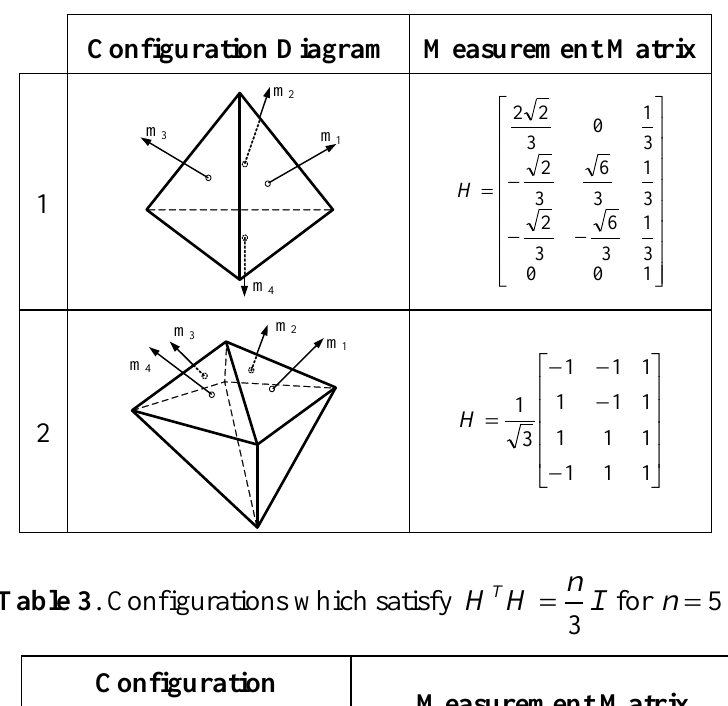
Table 2 . Configurations which satisfy Configuration Diagram